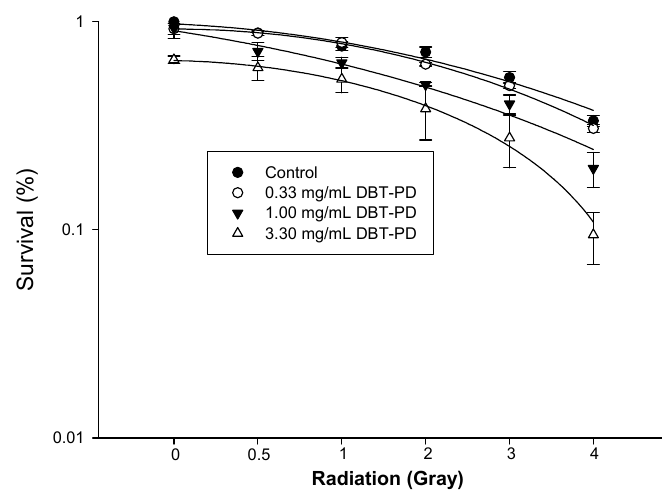
Figure 4. Radiation survival curve of CT26 cells. CT26 cancer cells were treated with 0.33, 1.00, and 3.30 mg/mL DBT-PD for 24 h before irradiation. Colony formation assay was performed for estimation of radiation survival. Data from 3 experiments are presented as mean ± standard deviation.